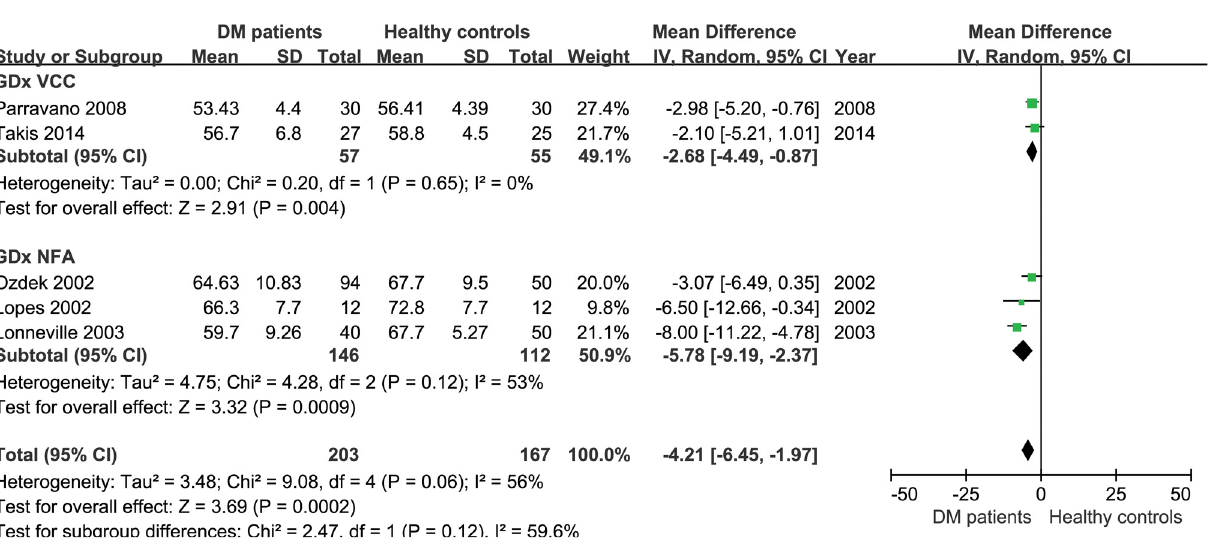
Fig 3. Meta-analysis of average RNFL thickness of diabetic patients and healthy controls in studies using SLP.